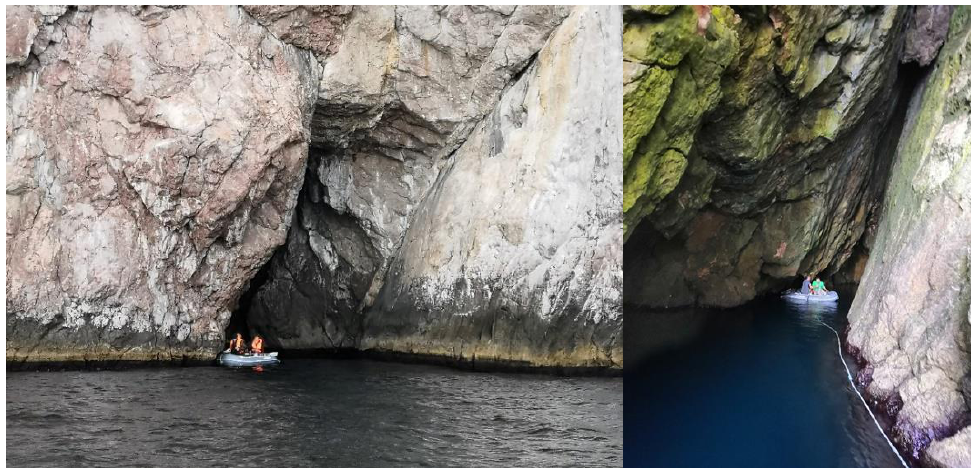
Figure 1. “Ekaterininsky grotto” near Cape Peleketo (research area near Cape Ayia). Photo taken by 24 March 2019.